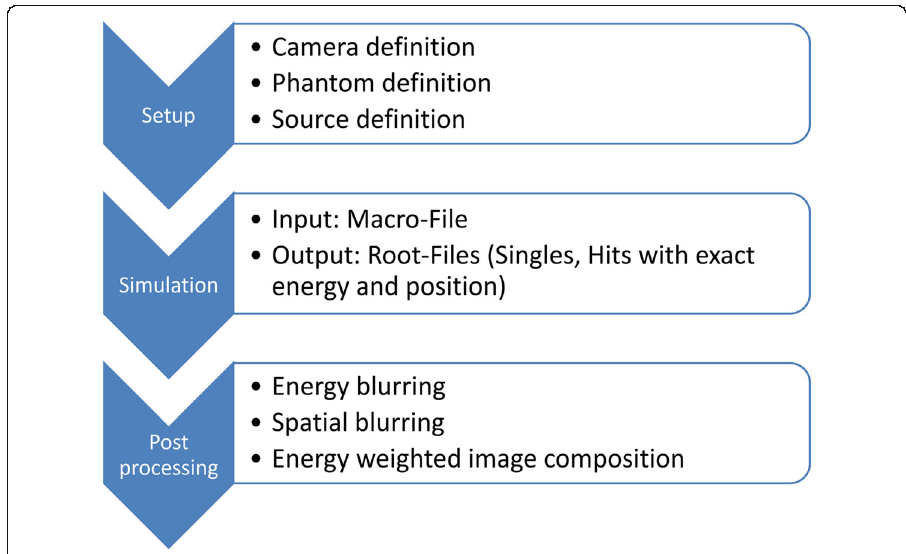
Fig. 3 Flow chart. Sequence illustrating the workflow of the GATE simulation and